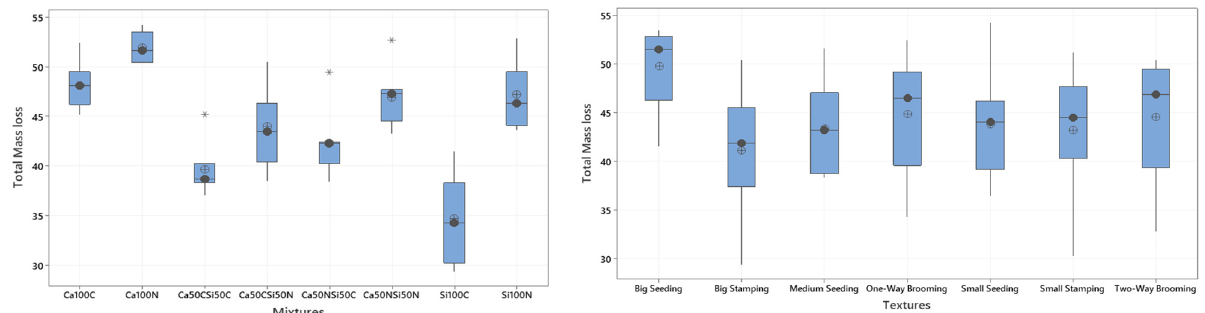
Figure 15. Comparison of abrasion resistance of different micro/macro-texture.